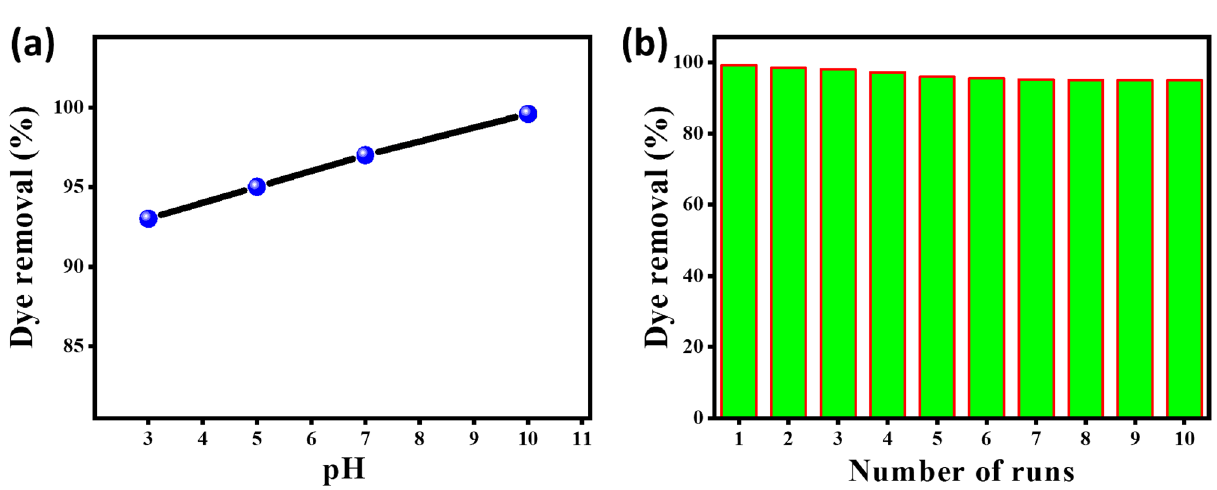
Figure 8. Effects of ( a ) different pH and ( b ) reusability on the adsorption process of 5 mg/L of MB dye on 50 mg of the AC500/NZ